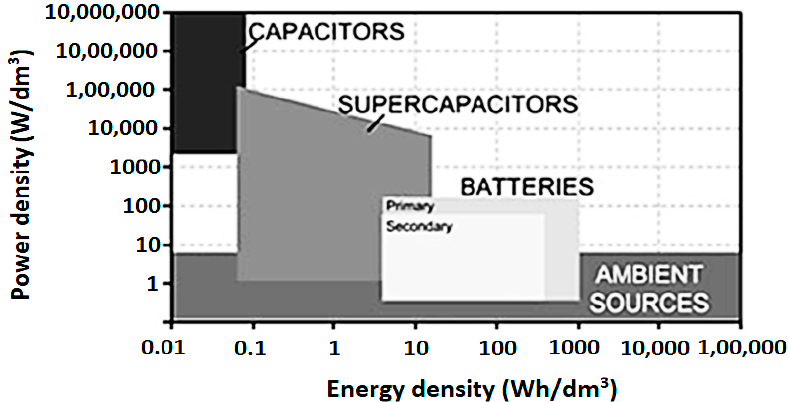
Figure 9. Power density and energy density of capacitor, supercapacitor, and batteries [51].